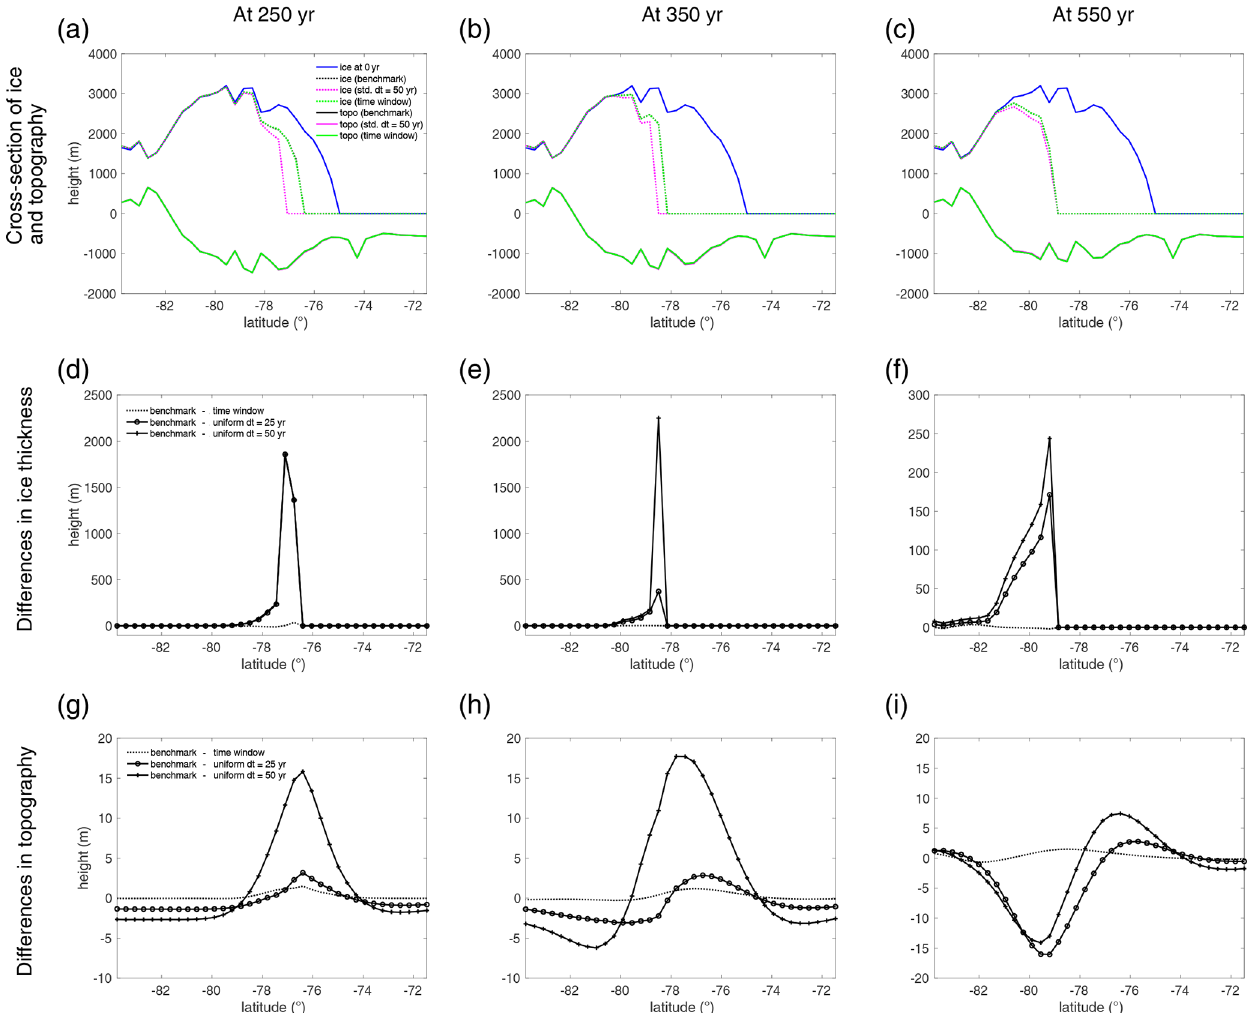
Figure 10. Predicted elevations of ice sheet and topography across the grounding line in the West Antarctic region (red line shown in Fig. 6g) in coupled ice-sheet–sea-level simulations with and without the time window algorithm and the differences in the predicted ice thickness and topography. (a–c) Cross section of ice thickness and topography at (a) 250 years, (b) 350 years and (c) 550 years. Blue lines indicate ice profile at the beginning of the simulation. Black lines show results from the benchmark standard coupled simulation that incorporates temporal resolution of 1 year, magenta lines show results from the standard simulation with dt = 50 years, and green lines show results from the simulation that incorporates the time window profile derived in Fig. 7. Dashed lines show ice thickness, and solid lines show topography. (d–f) Differences in ice thickness at (d) 250 years, (e) 350 years and (f) 550 years between the benchmark coupled simulation and the simulation incorporating the time window profile (dotted lines) and standard simulations with dt = 25 years (circled lines) and dt = 50 years (crossed lines). (g–i) Same as (d–f) but showing differences in